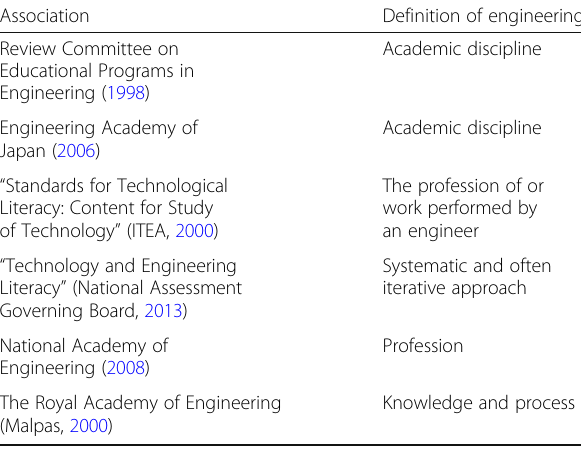
Table 2 Definitions of engineering by each